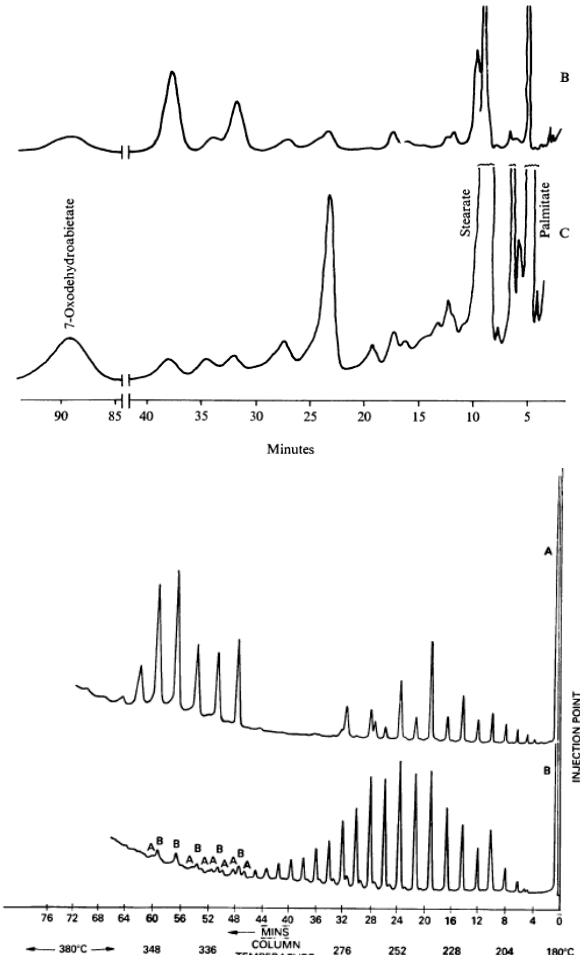
Figure 6. Comparison of packed column GC in isothermal with T -programmed mode. Top panel: Isothermal GC of resinous mate- rial in (B) an 18 th century anatomic wax model; (C) the wax model “Christ rejected by the Jews” by Giovanni Bologna, ca. 1579 [58] (chromatographic conditions as in ref. [54] ). Peak at 23.5 min, dehy- droabietate; 37.5 min, larixyl acetate. For details see Supplementary Information and ref. [58] . From ref. [58] with permission. Bottom pan- el: T-programmed GC. Samples: Waxes from (A) a surface coating of a 15 th century Intarsia work; contains bees wax, small propor- tion of ceresin wax; (B) 18 th century Italian wax sketch; contains a mixture of ozokerite with traces of bees wax (esters marked B). For details see Supplementary Information and ref. [59] . From ref. [59] with